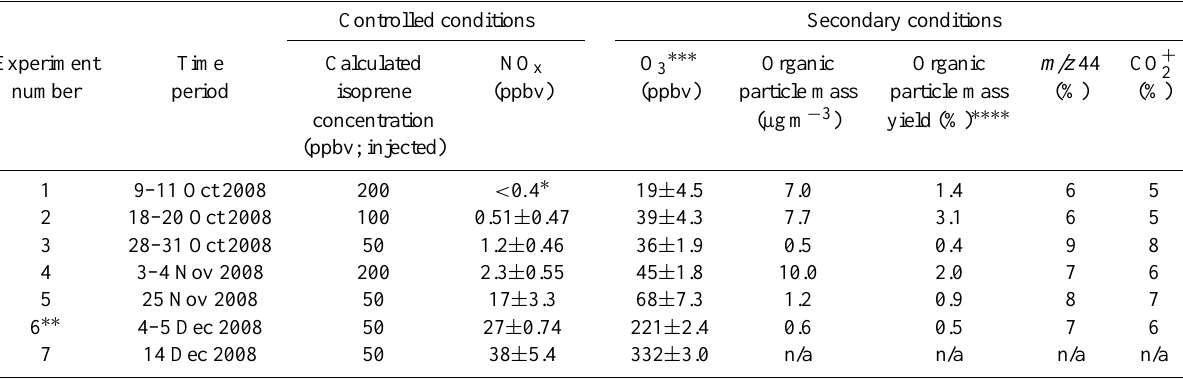
Table 1. Conditions of the seven experiments described in this study for the photooxidation of isoprene. Isoprene concentrations are listed prior to reaction. Concentrations of NO x , O 3 , and organic particle mass were measured at steady state. Mass yield is based on an estimate that 90% of isoprene reacts. The columns “ m/z 44” and “CO + ” represent the percent contribution to the total organic mass spectrum of 2 the particles (as recorded by the HR-ToF-AMS), where CO + is determined from the high-resolution data and m/z 44 is from the unit-mass 2 resolution data and includes contributions both from CO + and C 2 H 4 O + 2